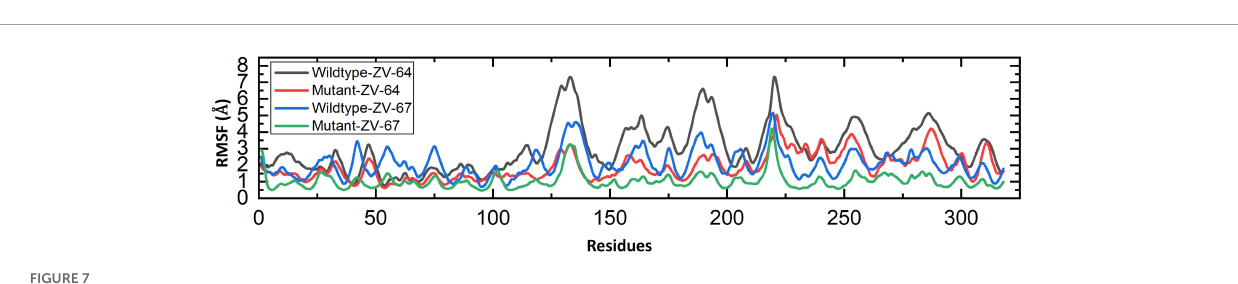
FIGURE7 RMFS calculated for the residual flexibility of all four